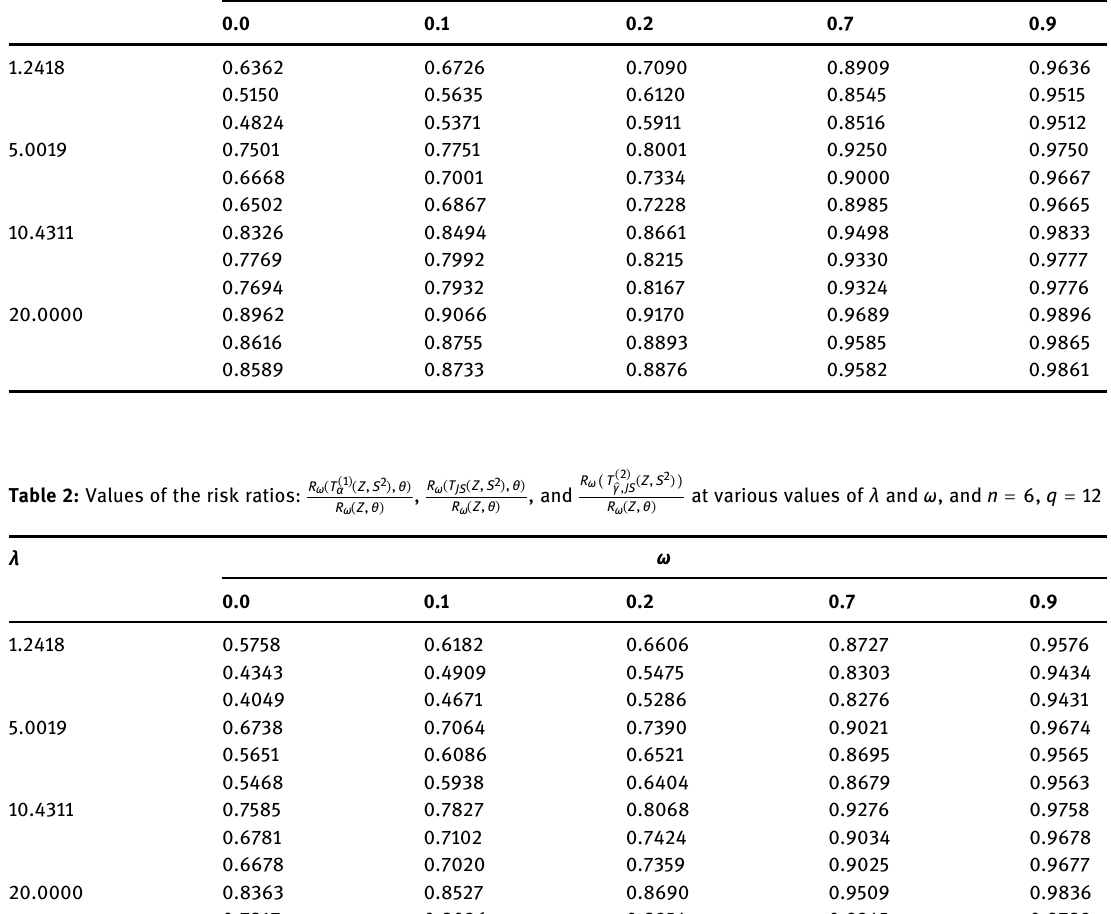
Table 1: Values of the risk ratios: R T Z S θ